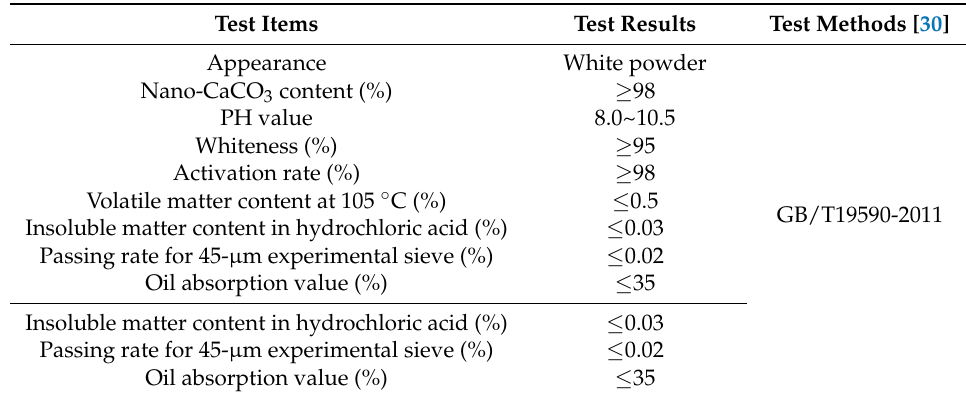
Table 4. Technical properties of nano-CaCO